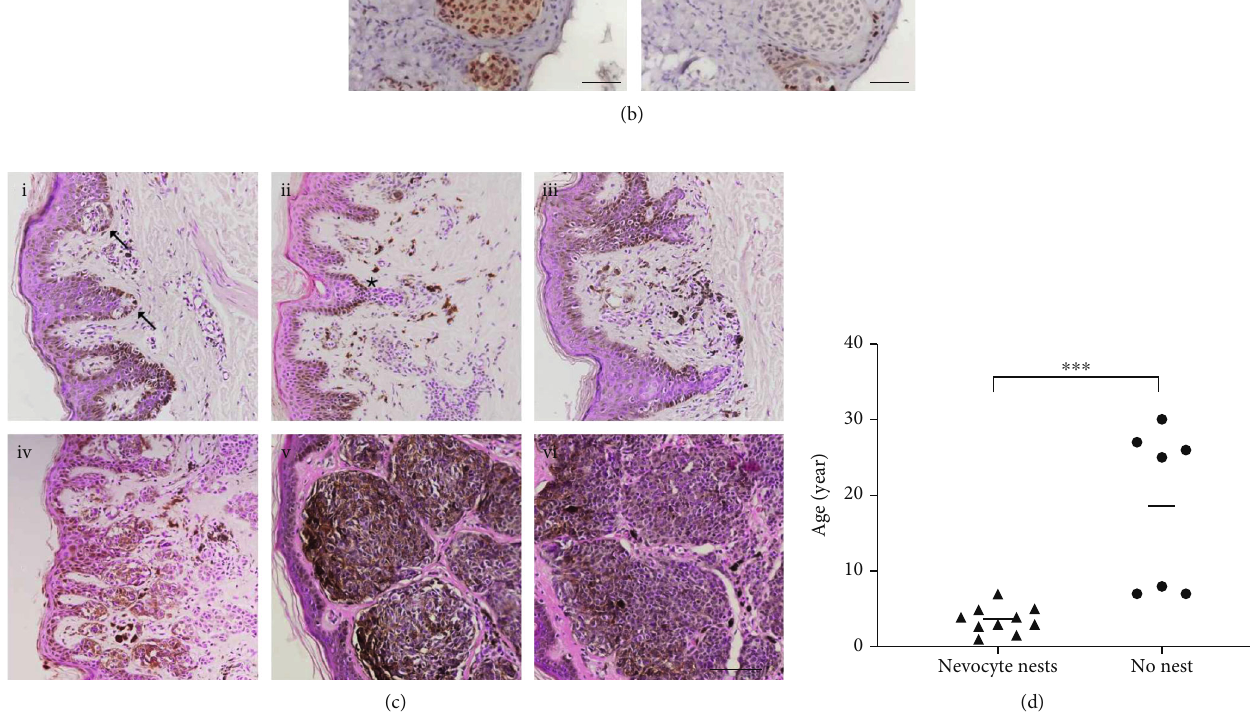
Figure 1: lgCMN develops from the epidermis to the dermis. (a) IHC staining of SOX10 in the smallest satellite nevus included in this study ( scale bar = 100 μ m). (b) IHC staining of SOX10 and Ki67 in nevocyte nests in serial sections ( scale bar = 50 μ m). (c) i. Nevocyte nests (indicated by the arrows) in the epidermal rete ridges and few nevocytes in the dermis of small satellite nevi; ii. the nevocyte nests expanded towards the dermis (indicated by the star); iii. nevocytes and melanin were presented in the dermis of satellite nevi but were limited to the super fi cial dermis; iv. a large number of nests penetrated the dermis; v. large nests in the dermis; vi. dispersed nevocytes and melanin in the dermis (H&E; scalebar = 100 μ m). (d) lgCMN patients without nests in the dermis appeared to be signi fi cantly older than those with nests in the dermis ( ∗∗∗ p value